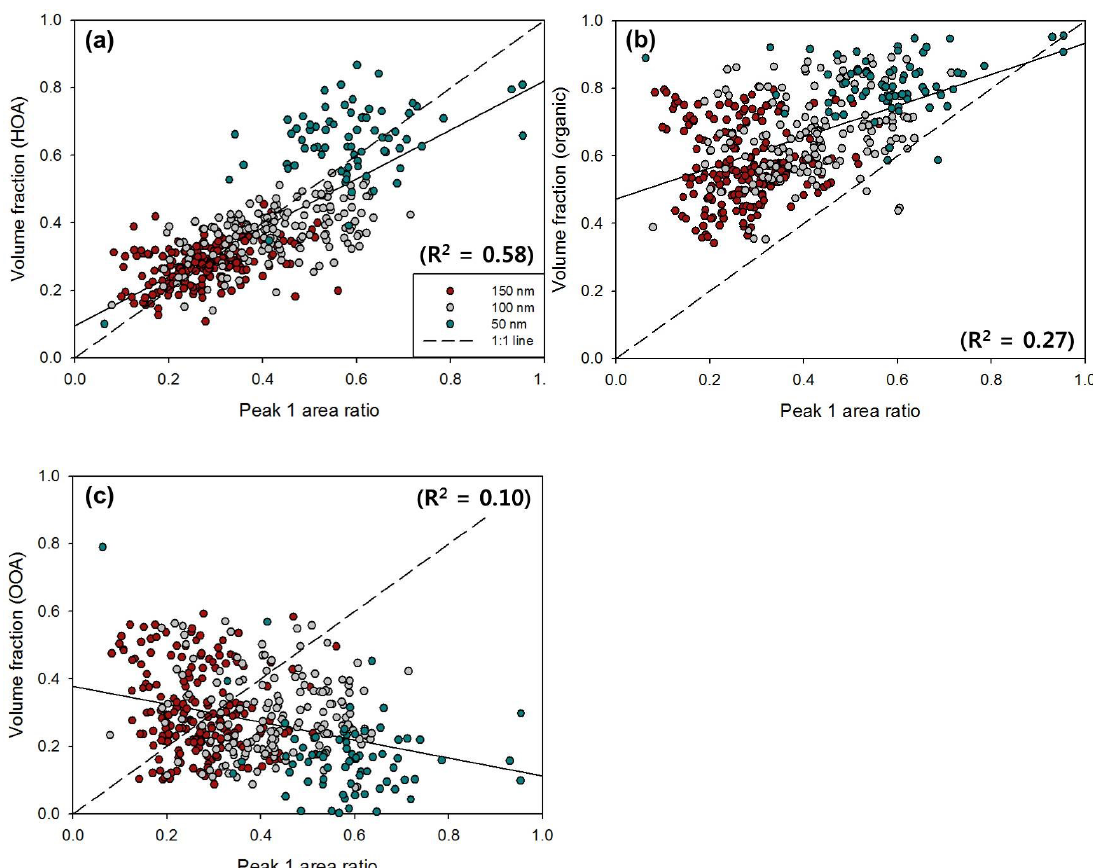
Figure 11. Scatterplots between Peak 1 (LH mode) area ratio and volume fraction of (a) HOA, (b) organics (HOA + OOA), and (c) OOA for 50nm (turquoise), 100nm (gray), and 150nm (red) particles. The dashed line and solid line represent the 1:1 line and linear regression line, respectively. The coefficient of determination ( R 2 ) of each scatterplot is